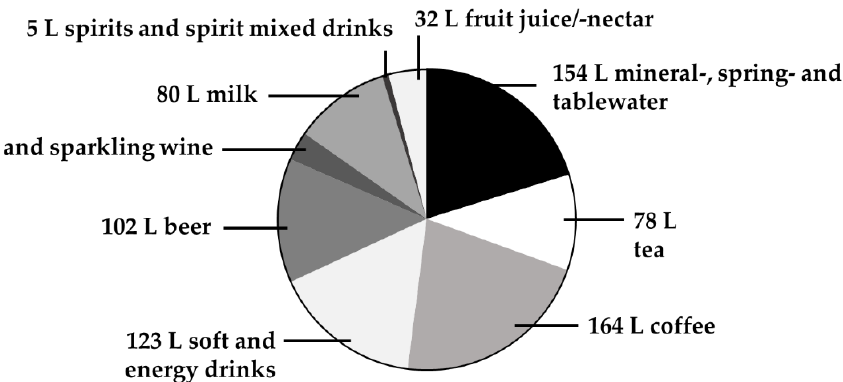
Figure 1. Annual per capita consumption of beverages (in litres) in Germany in 2018. Data are obtained from Statista [1]. Primary sources: German Wine Institute, Federal Office for Agriculture and Food, Associations of the German Beverage Industry. Obtained on 10 March 2020.